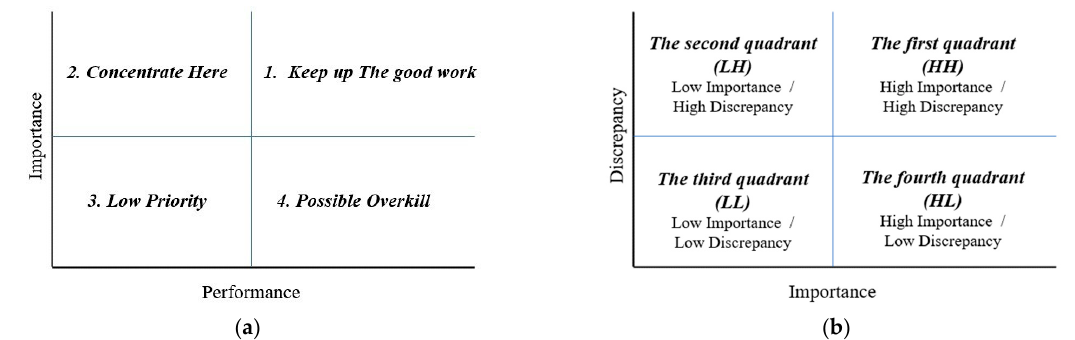
Figure 2. Schematic representation of the analysis: ( a ) importance—performance grid (IPA model); ( b ) locus for focus model.